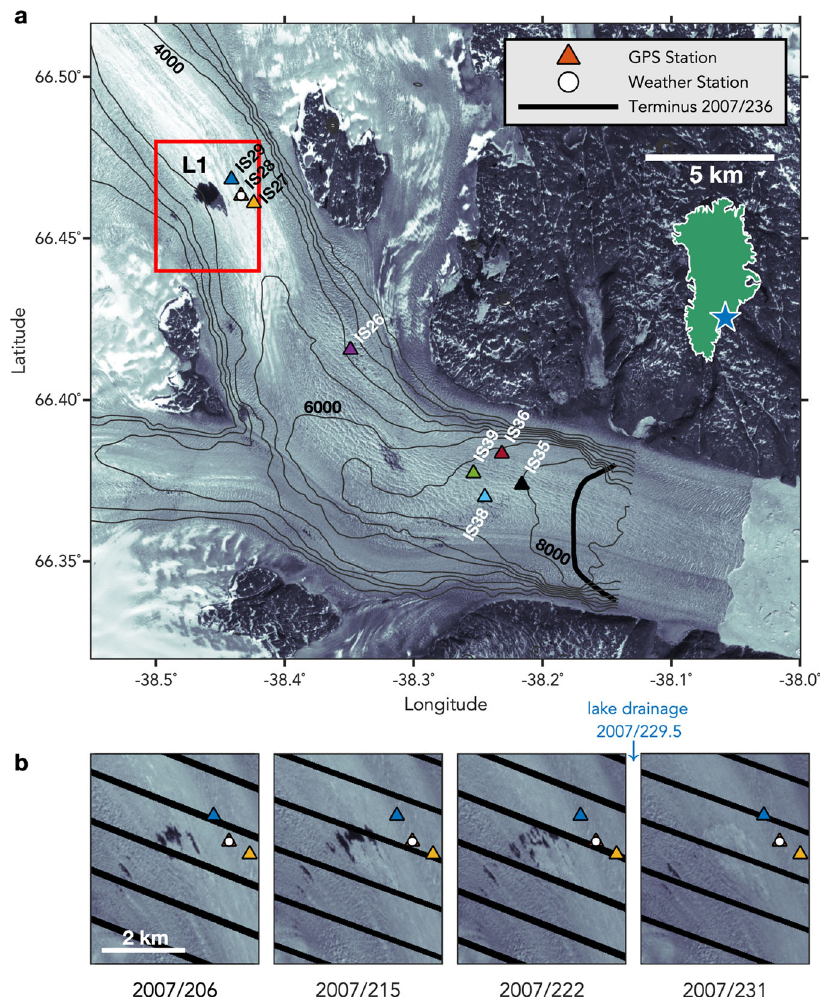
Fig. 1 | Helheim Glacier, East Greenland. a Landsatimage from 2001/182showing supraglacial lake L1, (triangles) GPS array, and (circle) Automatic Weather Station (AWS) deployed in 2007. (thick black line) Glacier terminus position on 2007/236. July2007surfacevelocities 64 showninblackcontoursat1000myr − 1 intervals.Inset